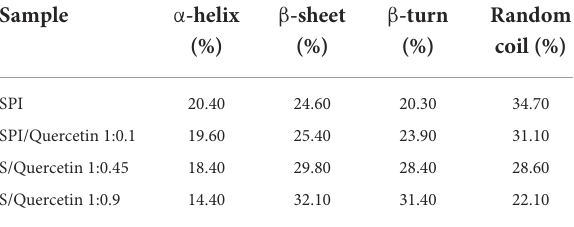
TABLE 2 Percentage of different secondary structures in SPI and SPI-quercetin